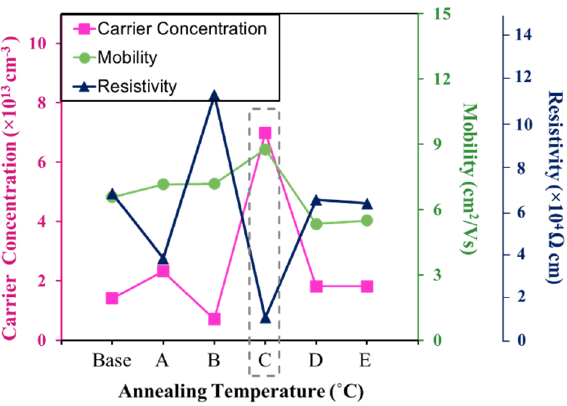
Figure 11. Changes in electrical parameters of CdTe thin film for various annealing temperatures.